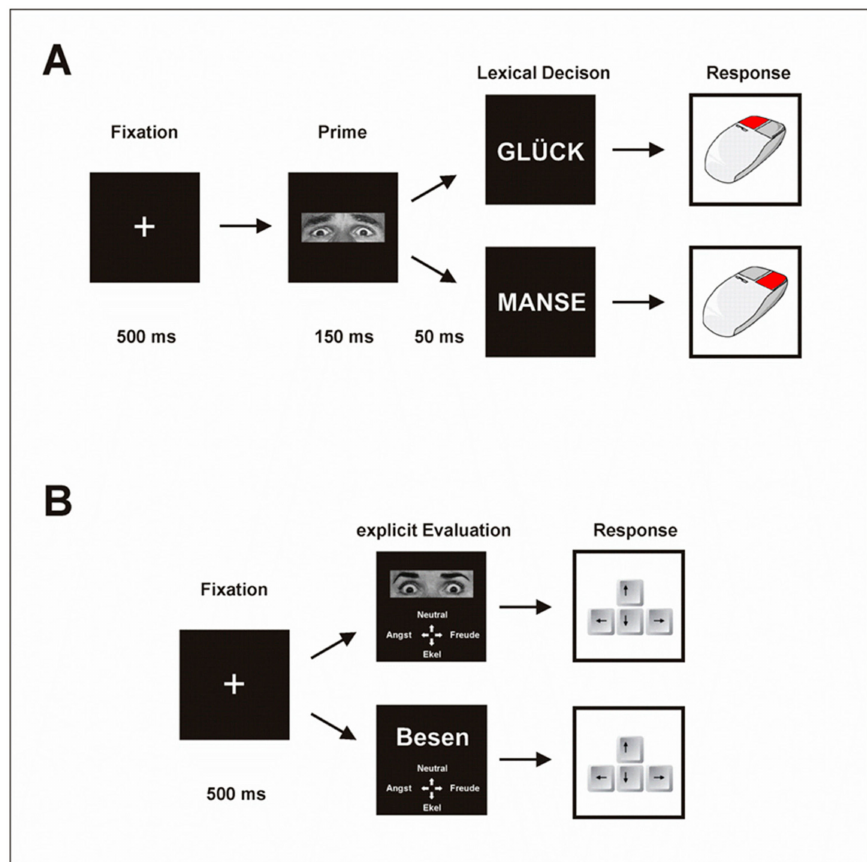
Figure 1. A ff ective priming paradigm including ( A ) the lexical decision task (LDT) of the implicit task and ( B ) the explicit task with the evaluation of emotional stimuli. ( A ) Each trial in the LDT started with a fixation cross that was presented for 500 ms. An emotional prime (the adjusted eye region of Ekman-faces-photographs) followed and was displayed for 150 ms followed by a break of 50 ms. Subsequently, the target stimulus was presented without a time limit. The participants were supposed to decide as fast as possible whether this target was a real German word or a pseudo-word and to press a corresponding button on a computer mouse. After the button press, the next trial started. ( B ) In the second task, participants were requested to explicitly decide which emotional category the presented stimulus material belonged to. Each trial started with a fixation cross that was presented for 500 ms. After a further 50 ms break, the stimulus was presented. Participants were instructed to press one of the four buttons on a keyboard which corresponded to the emotional category of the stimulus as fast as possible. No time limit was given. First, the eye regions were presented, afterward the real German words